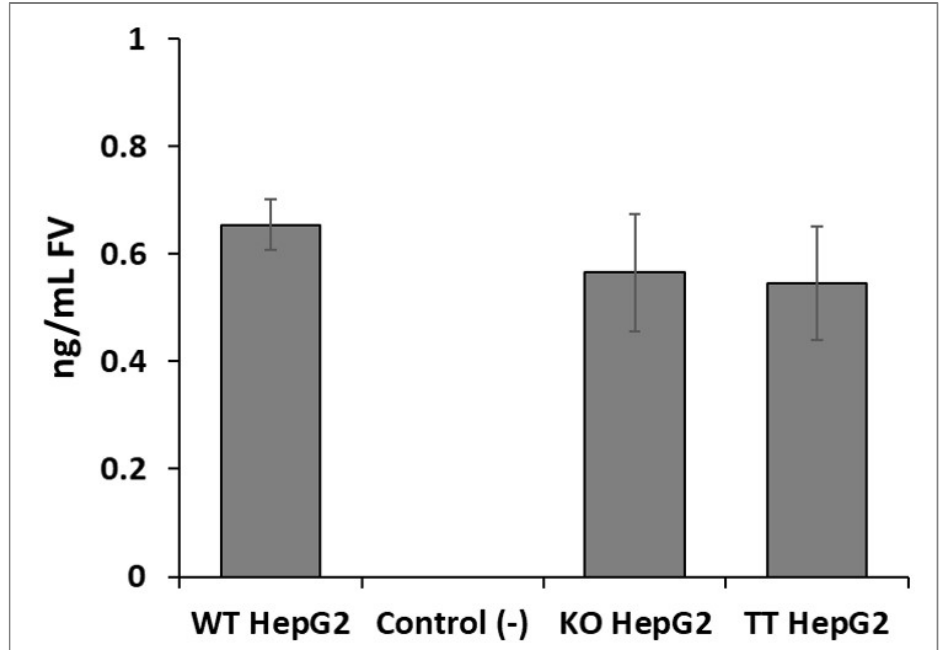
Figure 5. Application of the Human Coagulation Factor V ELISA assay to different HepG2 cell lines (WT HepG2, KO HepG2 and TT HepG2). Control ( − ) Oval cells and SW480 as negative controls. Figure presented as mean ± SD ( n = 3).